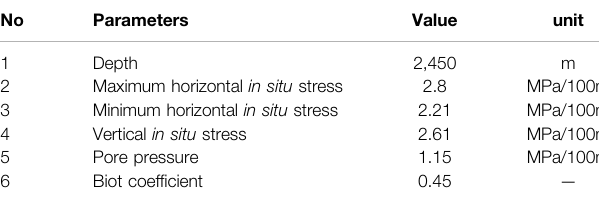
TABLE 3 | Geomechanical parameters of Longmaxi Formation in Fuling.